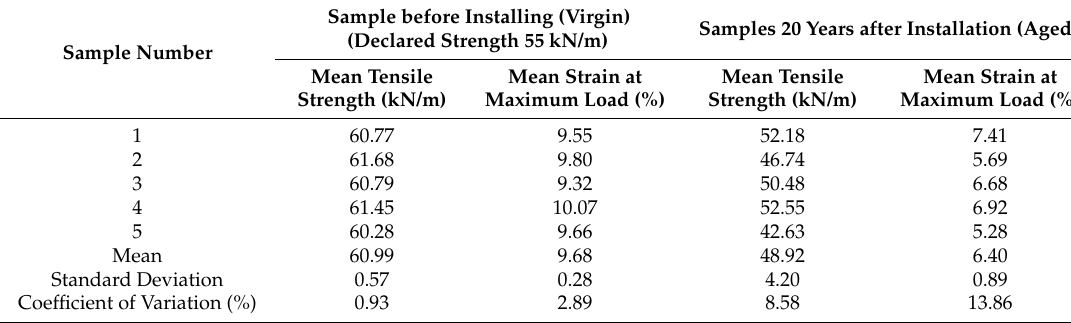
Table 2. Results from a wide range of tests for virgin (new) and aged geogrid samples.